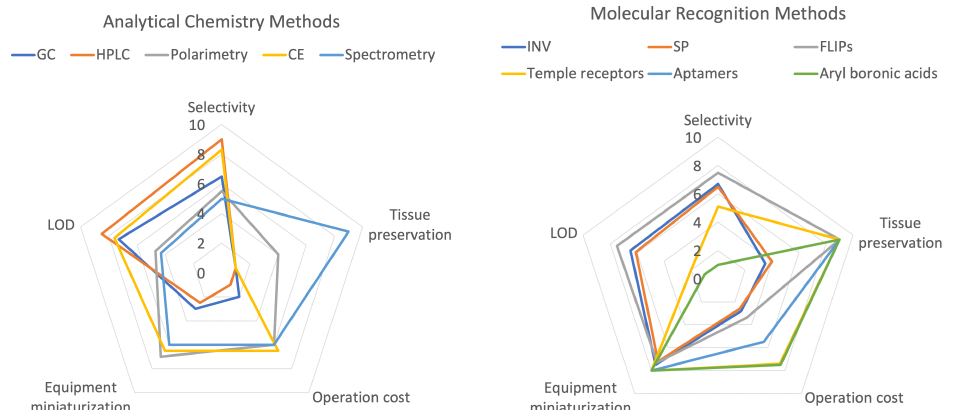
Figure 16. Qualitative comparison, on a scale from 0 (worse) to 10 (best), between the analytical chemistry ( left ) and the molecular recognition methods ( right ) for the quantification and detection of sucrose. We selected the LOD and selectivity for sucrose, tissue preservation, operation cost, and the miniaturization of the equipment, as important criteria to evaluate the potential use of these techniques for real-time sucrose quantification under in vivo